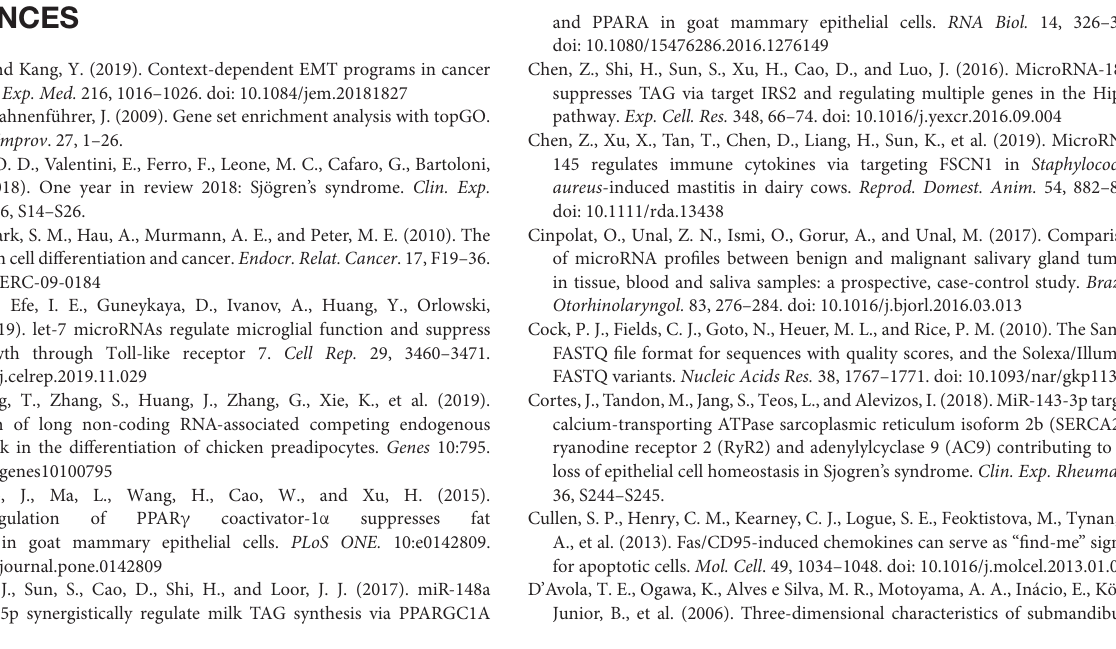
Supplementary Table 1 | The qRT-PCR primers used for validation. Supplementary Table 2 | Results of miRNA